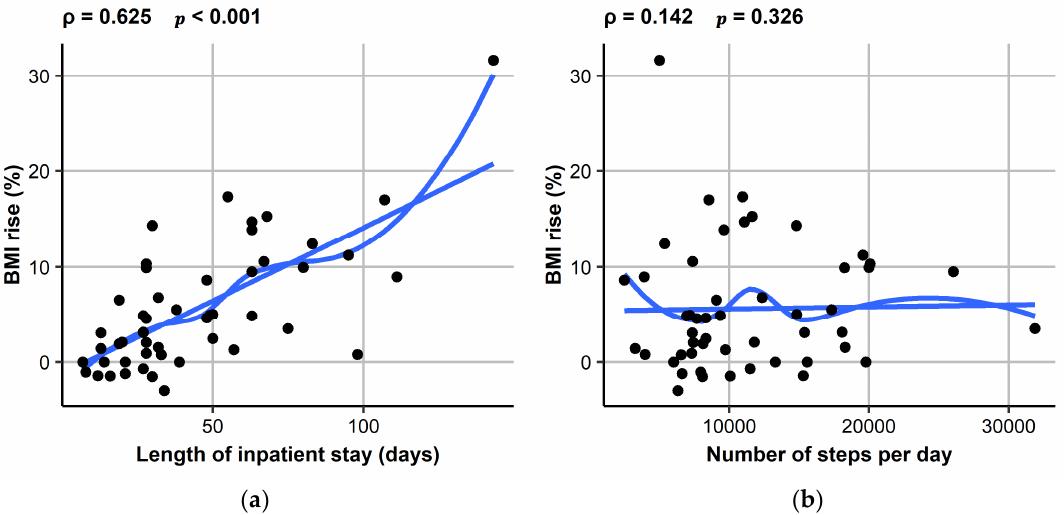
Figure 1. Associations between BMI increase in % and ( a ) length of inpatient stay and ( b ) number of steps per day applying Spearman rank correlation. BMI, Body Mass Index.